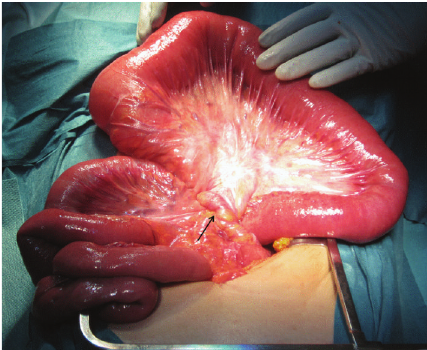
Figure 2: Distal ileum twisted behind the mesentery of the afferent loop (arrow).